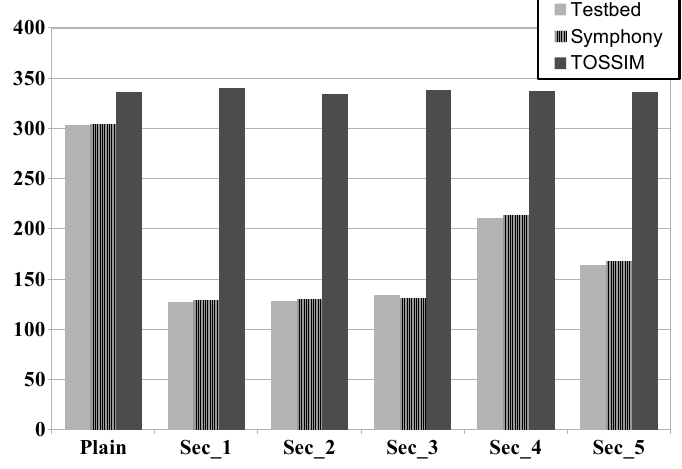
Figure 11. Comparison of accuracy when simulating security algorithms in Symphony, TOSSIM and experiment with real nodes. X-axes shows a comparison of different security algorithms, while on Y-axes thenNumber of received packets by sink is